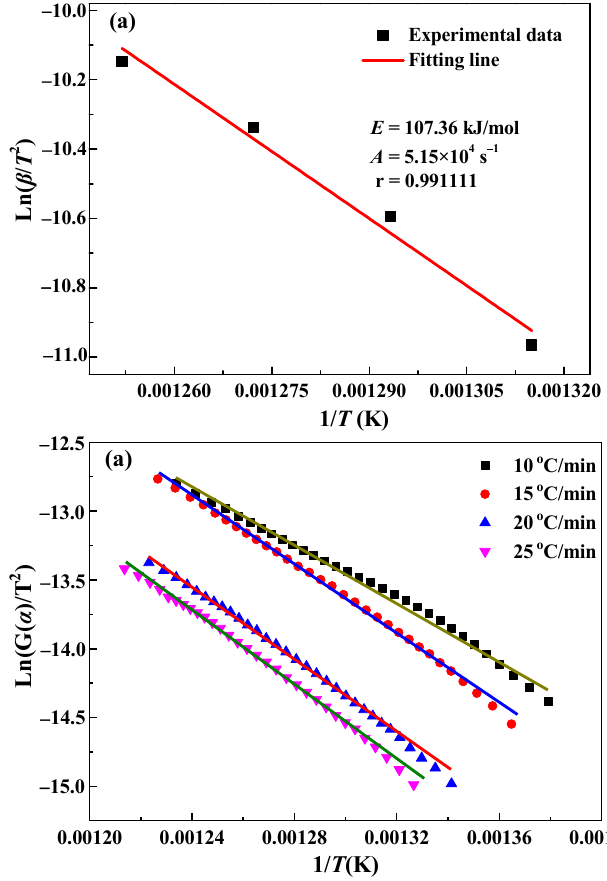
Figure 9. Kinetic fitting of the ( a ) Kissinger and ( b ) general integration methods.